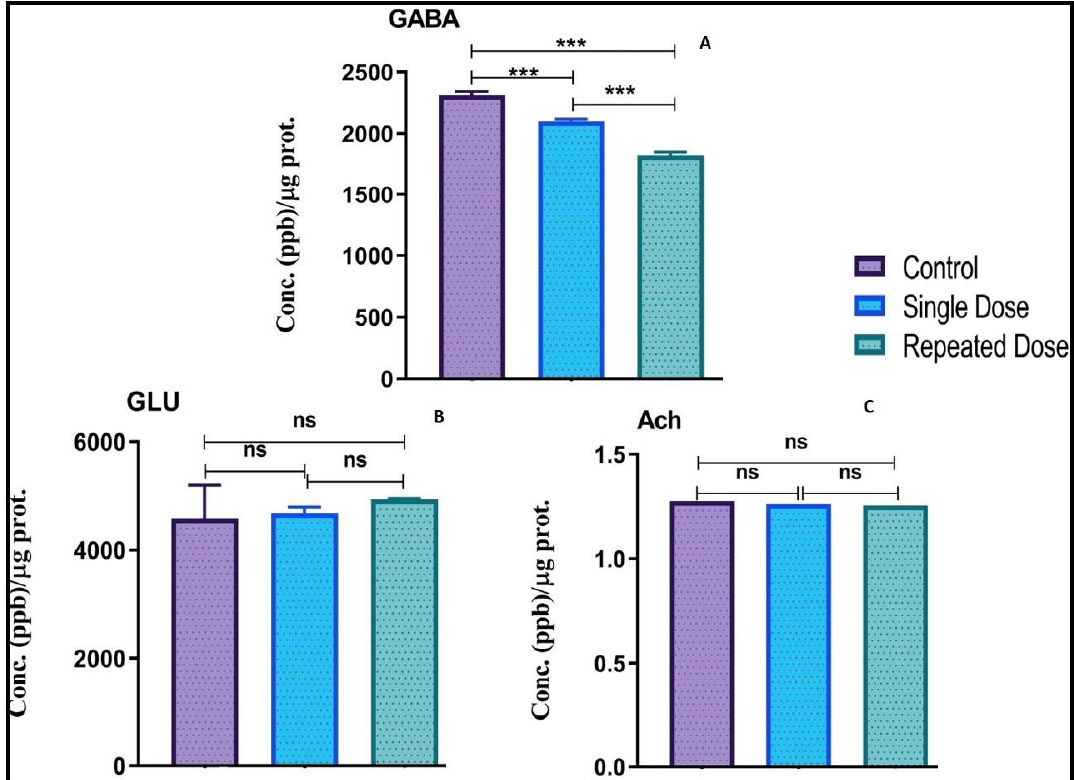
Figure 7. Modulation of Neurotransmitters levels in the normal and epileptic group. Neurotransmitters analysis in zebrafish brain after 10 days of pilocarpine treatment. GABA ( A ), Glutamate (GLU) ( B ), and Acetylcholine (Ach) ( C ) levels were estimated in the zebrafish brain using LC-MS/MS. Data are represented as mean ± SEM, n = 6 and statistically analyzed by one-way ANOVA followed by Sidak’s multiple comparison test * p < 0.05, ** p < 0.01, and *** p < 0.001.